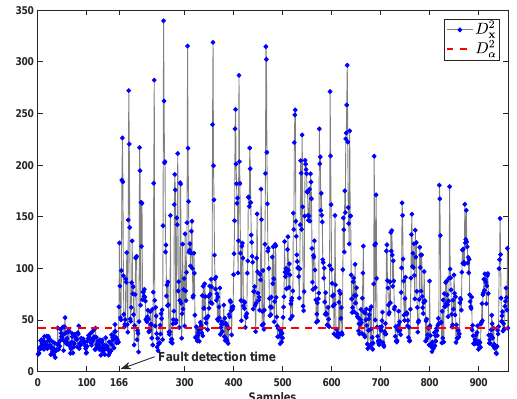
Figure 15. The fault detection results by kNN for fault 11 of TE.